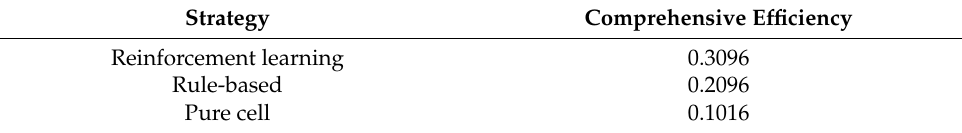
Table 5. Efficiency